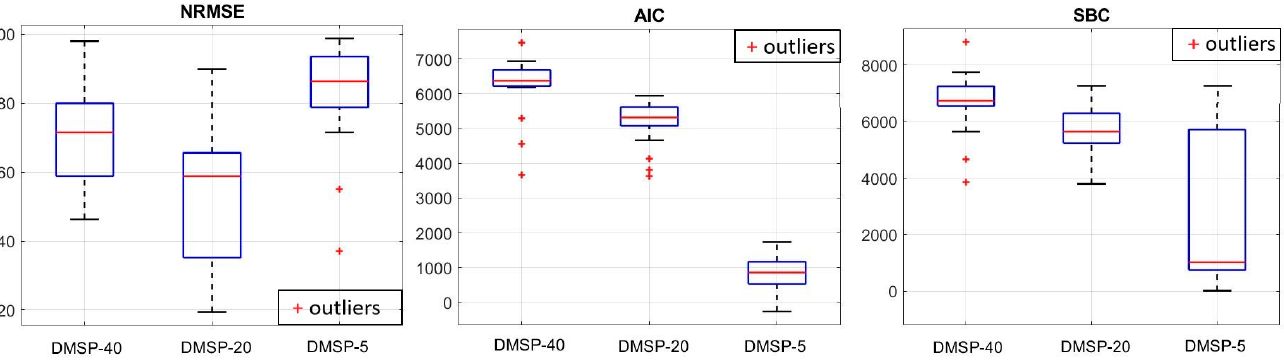
Figure 17. Summary of the results of the models of all architectures for each of the modeled muscle types using the selected performance metrics.